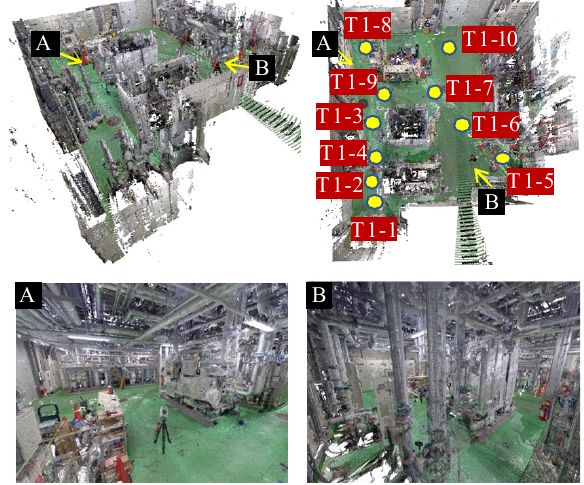
Figure 4. Point clouds of Dataset A